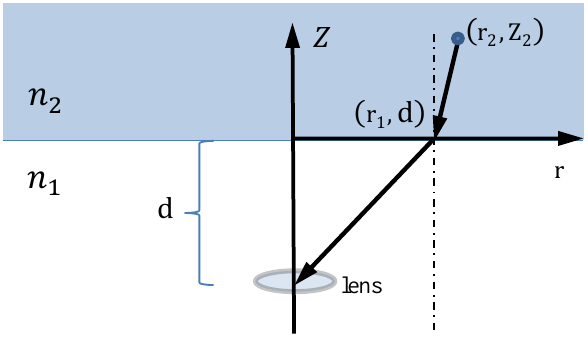
Figure 2. The ray from a 3D point in the medium intersects the refraction plane, modified from (Treibitz et al.,